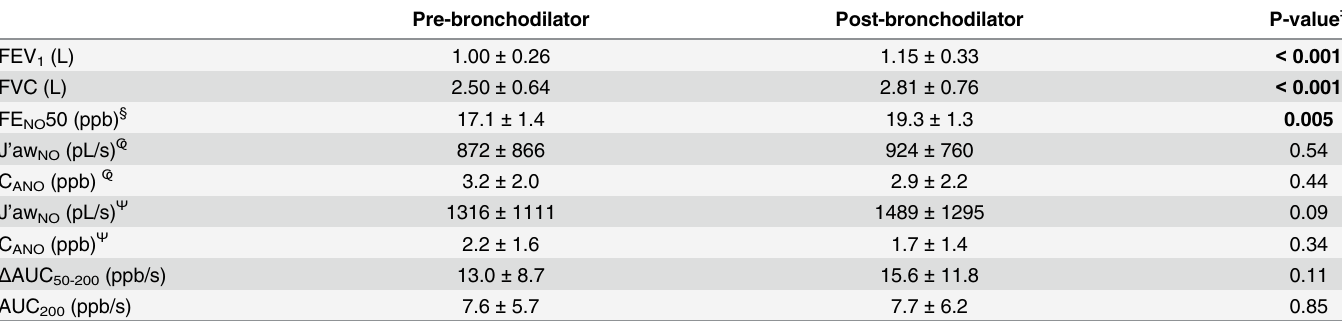
Table 2. Pre- and post-bronchodilator spirometry, FE NO 50 and flow-independent pulmonary NO parameters in 21 patients with COPD.